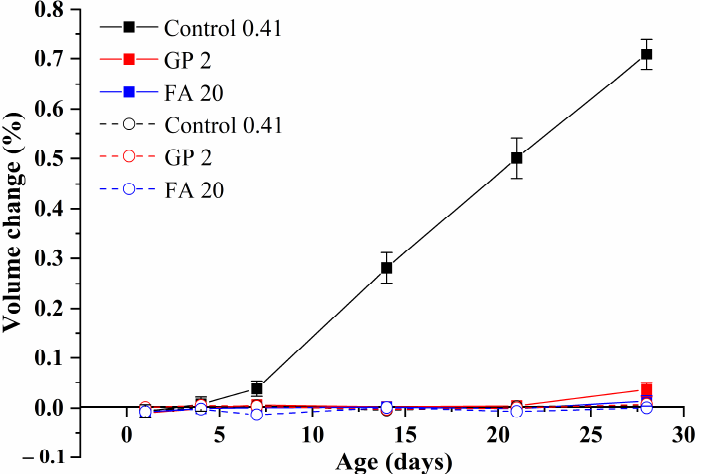
Figure 13. Volume changes of GP 2 and FA 20 mortars under alkali curing at 80 °C (solid line) and water curing at 80 °C (dash line).